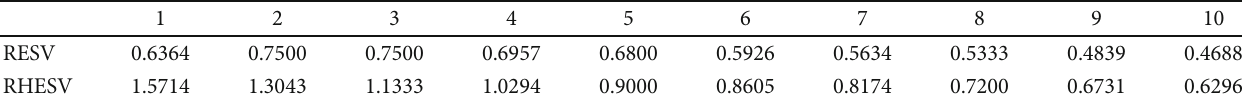
Table 3: The relative lifting rate of fi ve targets.